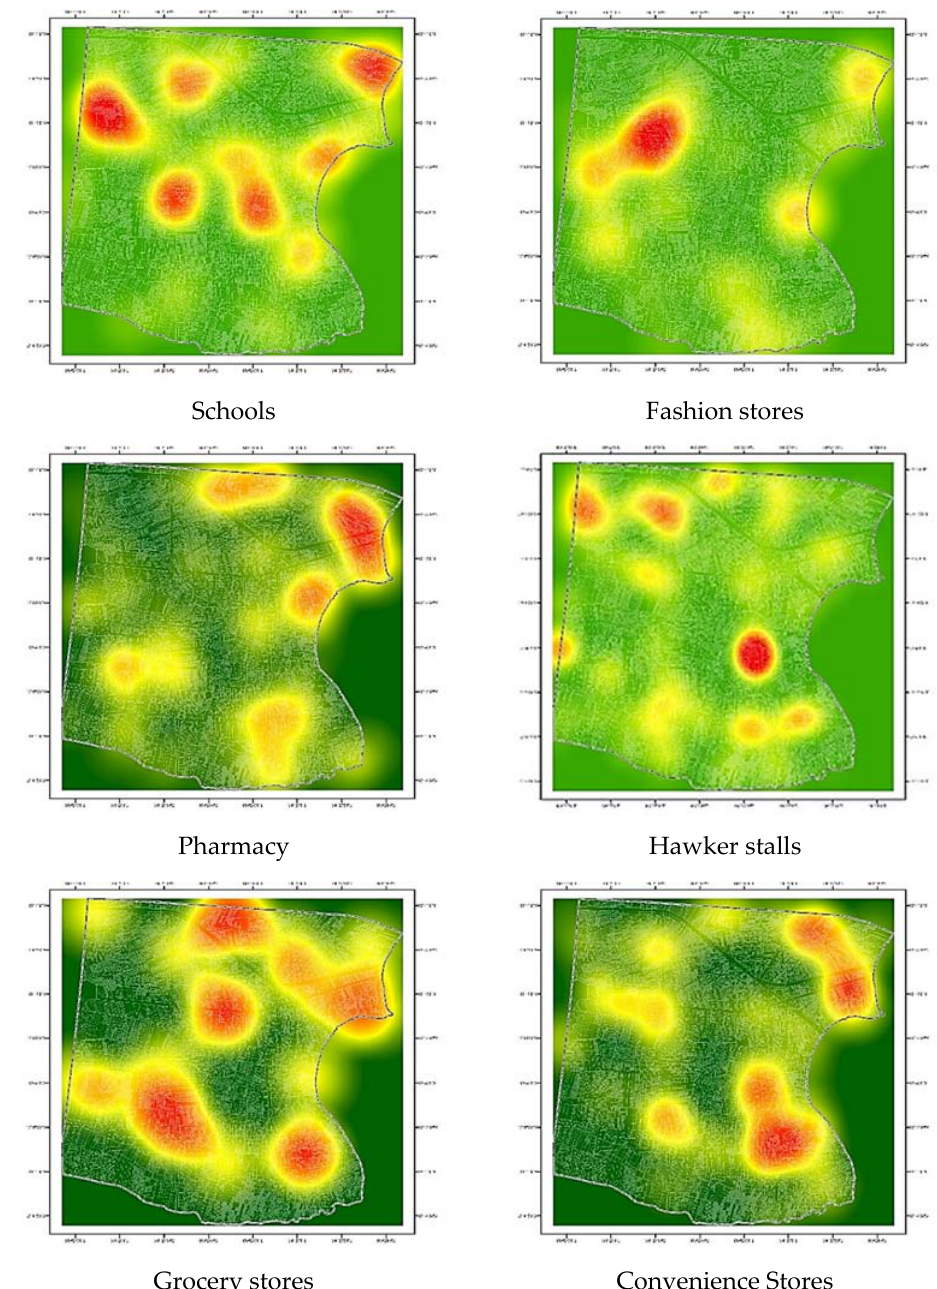
Figure 2. Kernel density estimation of independent variables.